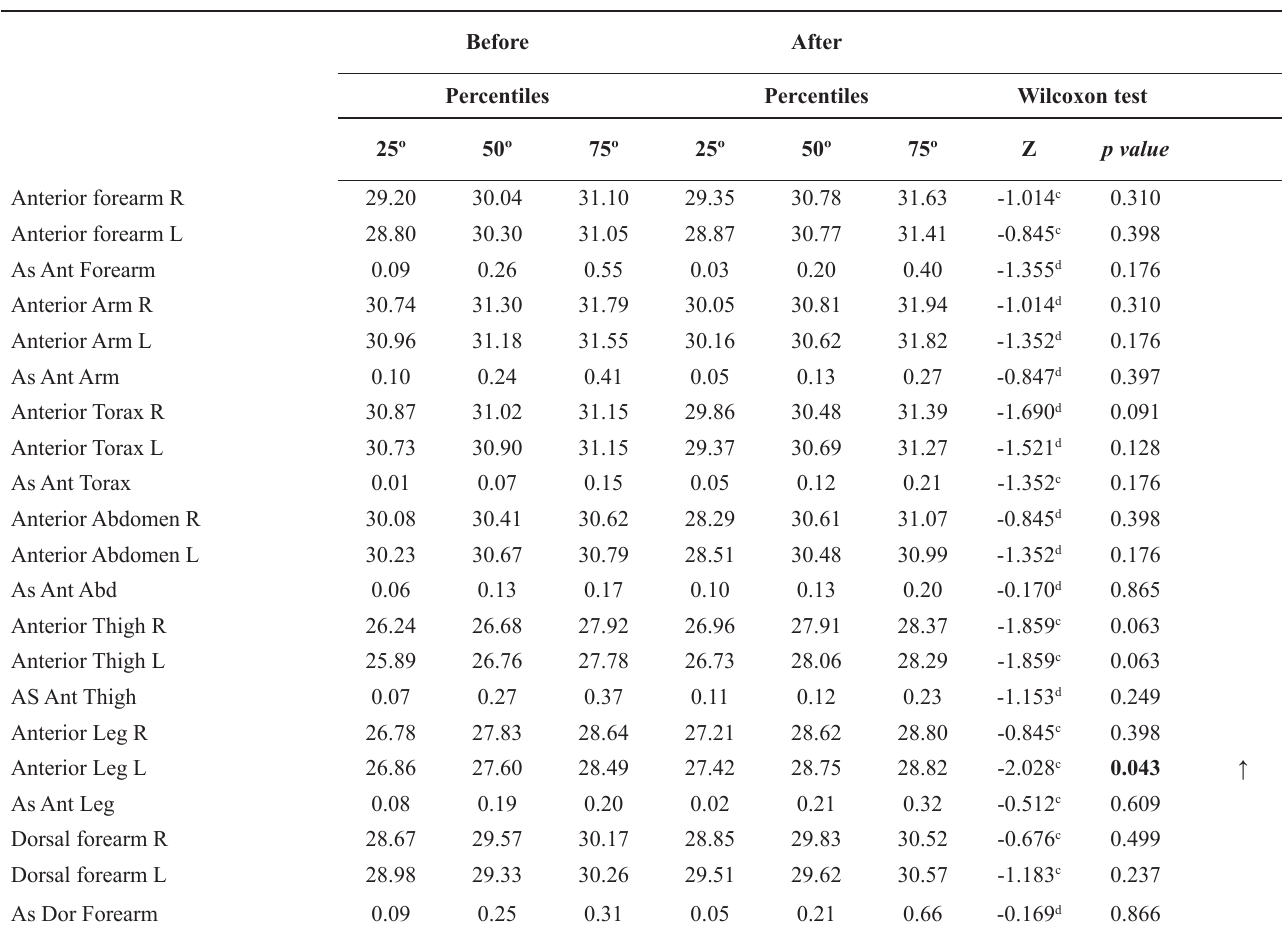
Table 4 - Skin temperature and thermal asymmetries measures of 7 female volunteers, before and after a session of CrossFit® training , Vila Real, Portugal, 2019